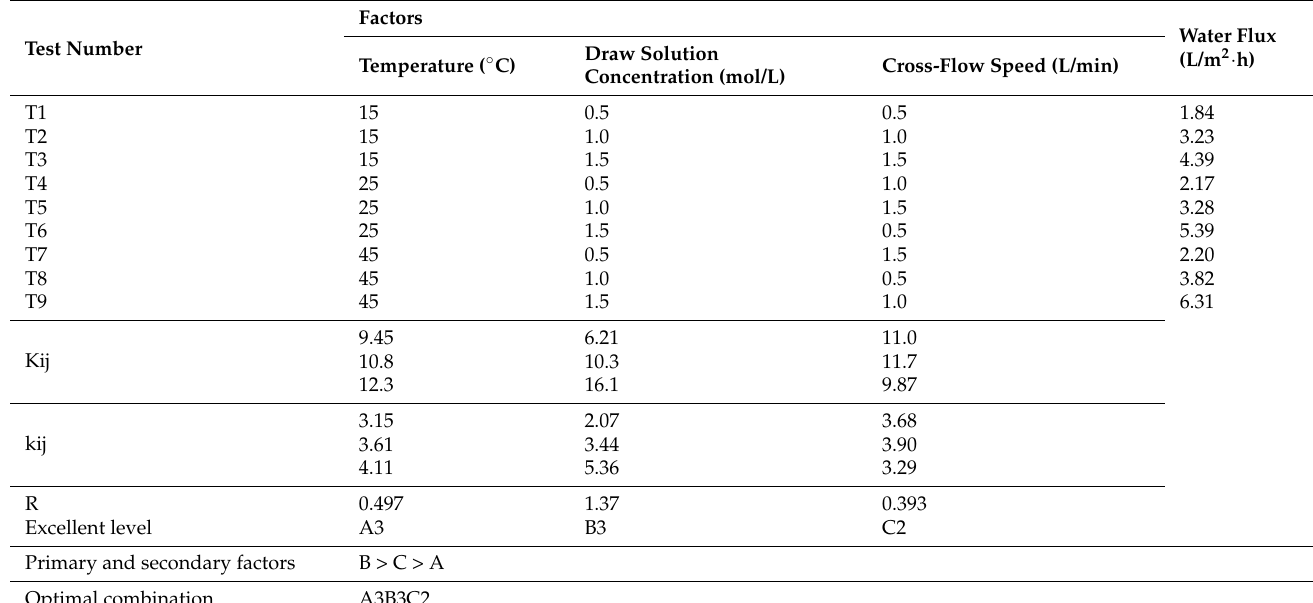
Table 2. Orthogonal analysis of FO membrane